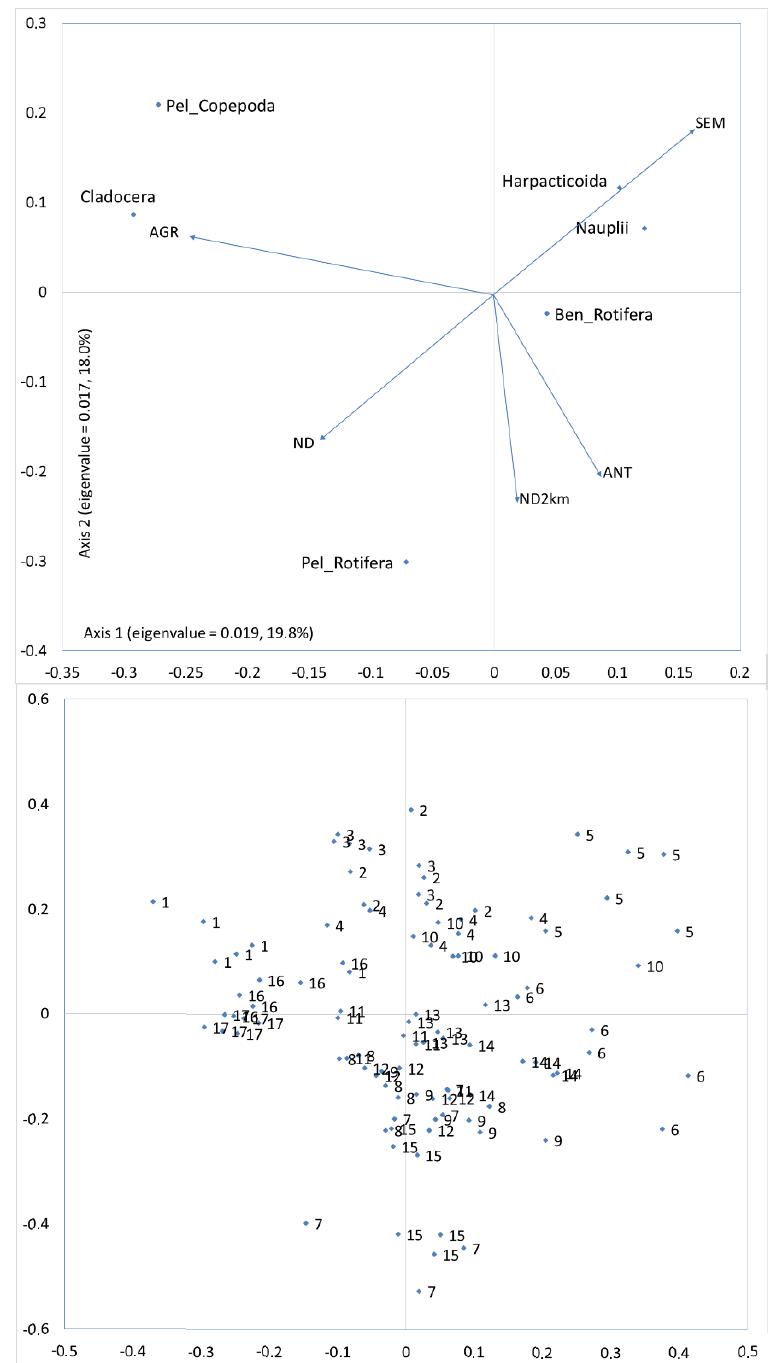
1 Figure 6. Abundance and factors of the anthropogenic changes in the catchment and in the river bed: canonical correspondence analysis (CCA) constrained ordination of samples and taxa from sites with different current velocity in ditches with the forward selection procedure of environmental